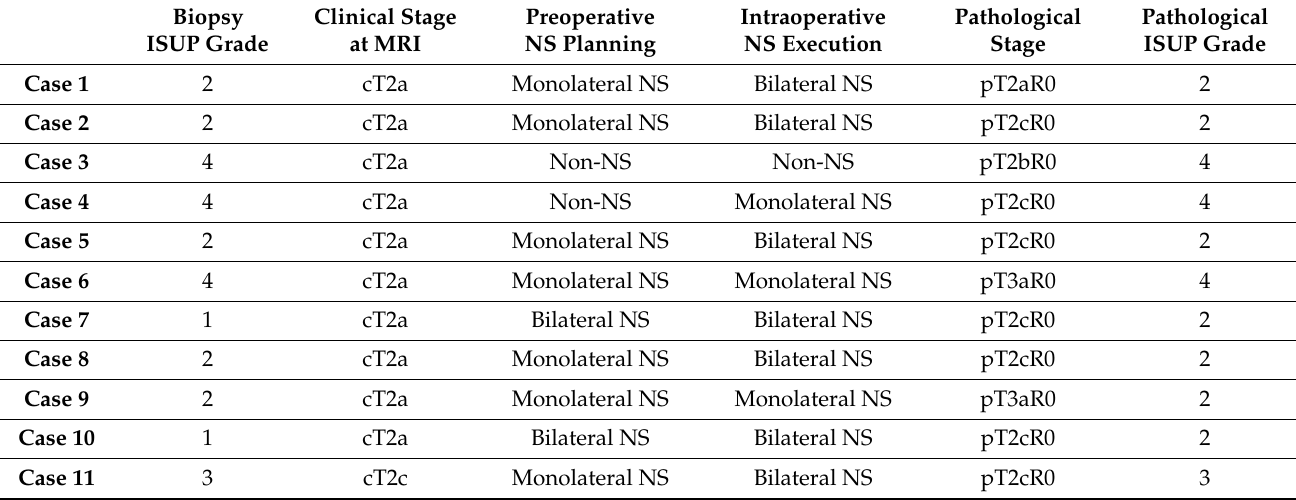
Table 2. Impact of 3D modeling on surgical planning and comparison between clinical and pathological